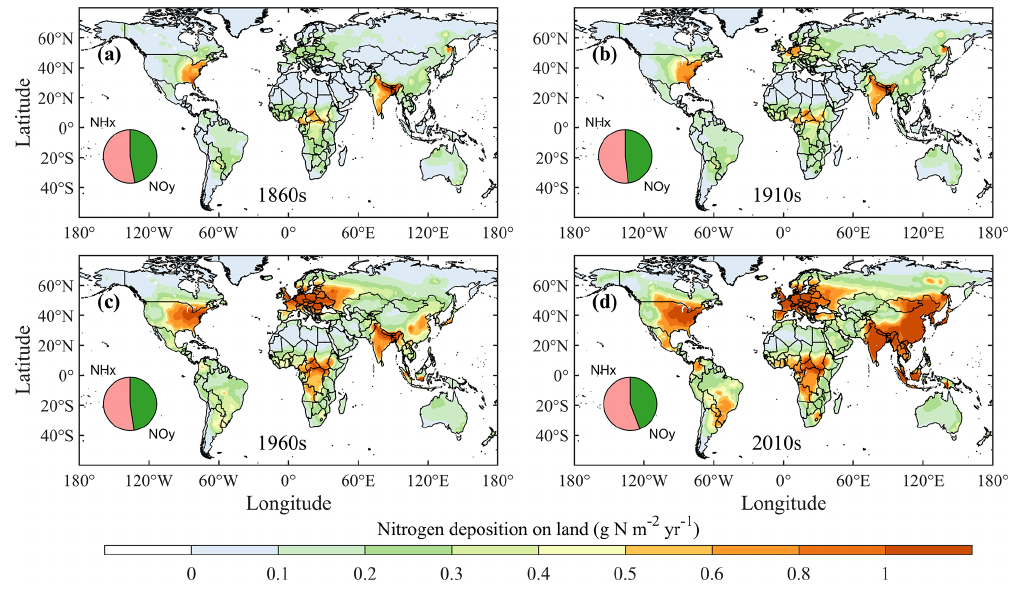
Figure 11. Spatial patterns of atmospheric N deposition on land in the 1860s, 1910s, 1960s, and